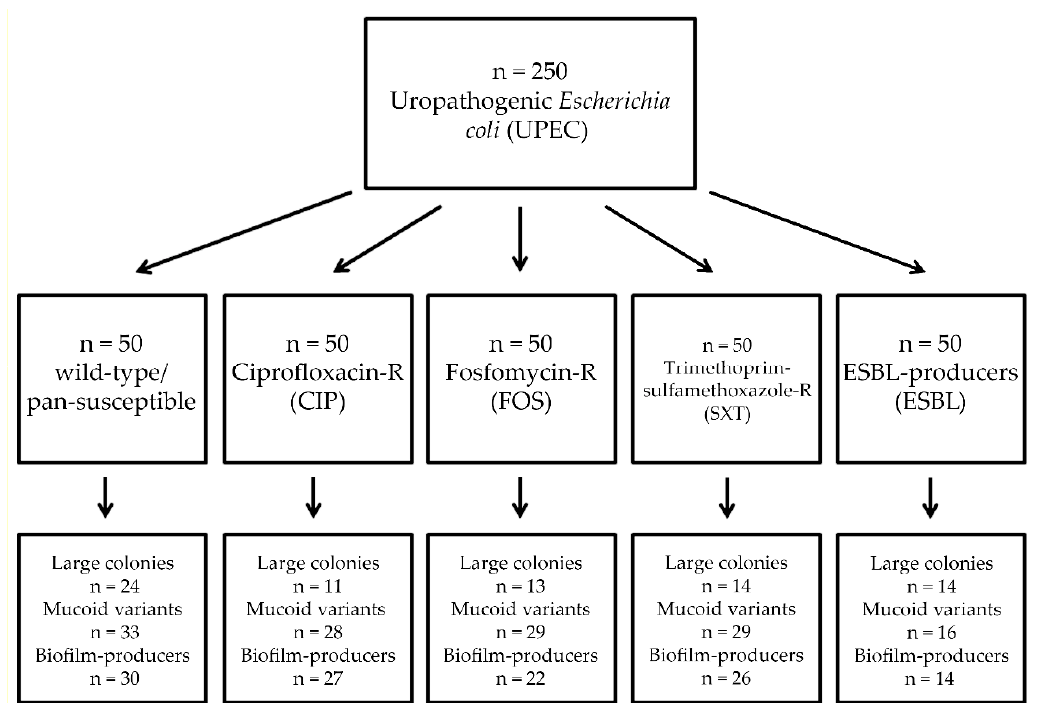
Figure 1. Summary of the experimental results in the different groups of uropathogenic Escherichia coli (UPEC) .